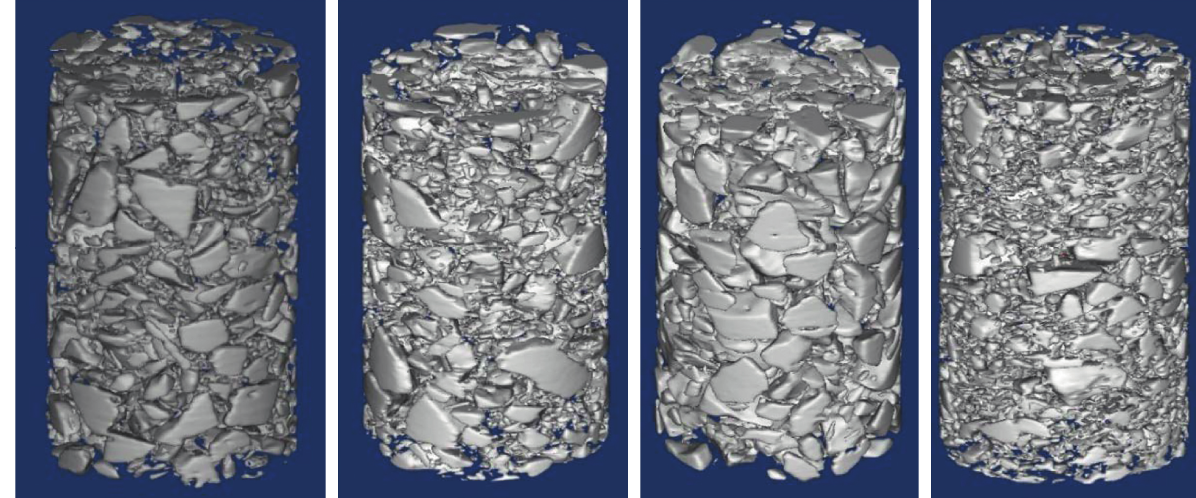
Figure 11: Reconstructed virtual specimens (PA13, AC13, SMA13, and SUP13, from left to right).